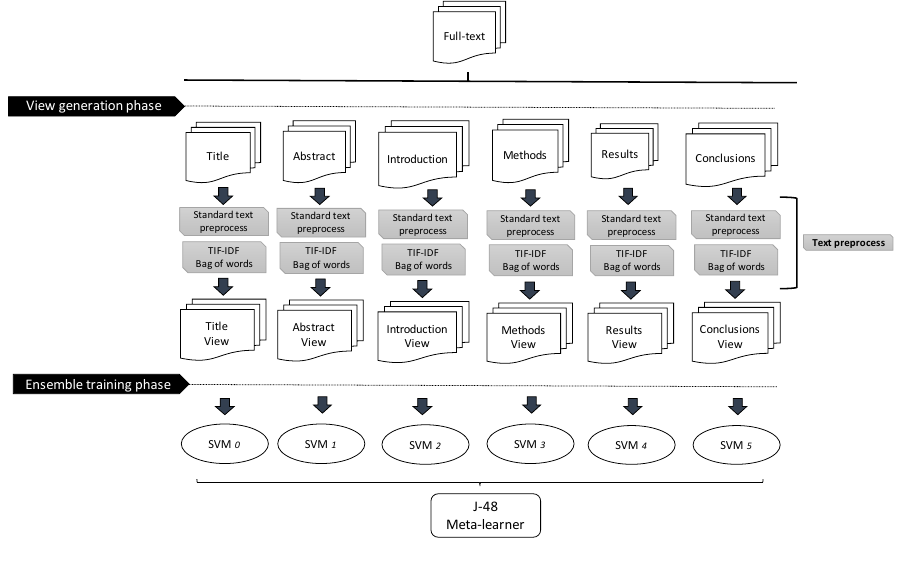
Figure 3. Experimental